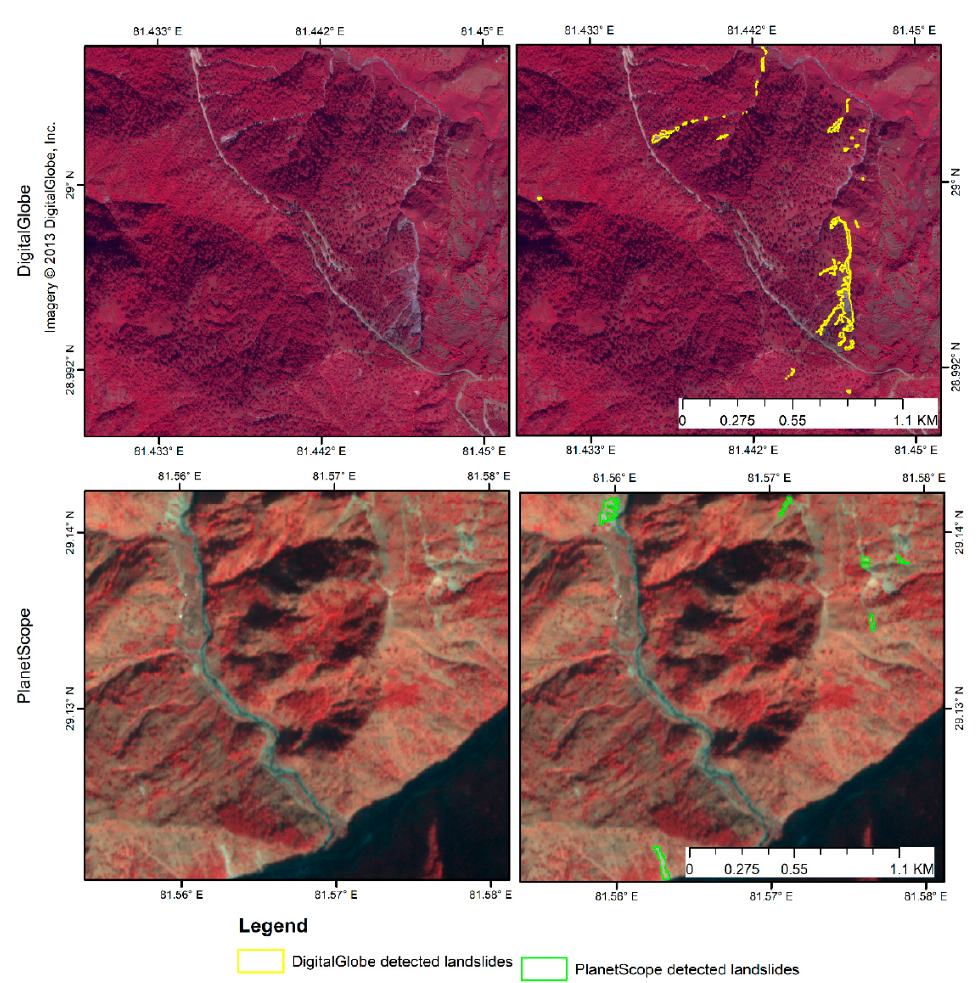
Figure 6. Subset areas showing the OBIA detected landslide along the Karnali highway obtained from DigitalGlobe ( top ) and PlanetScope ( bottom ) for two separate locations.